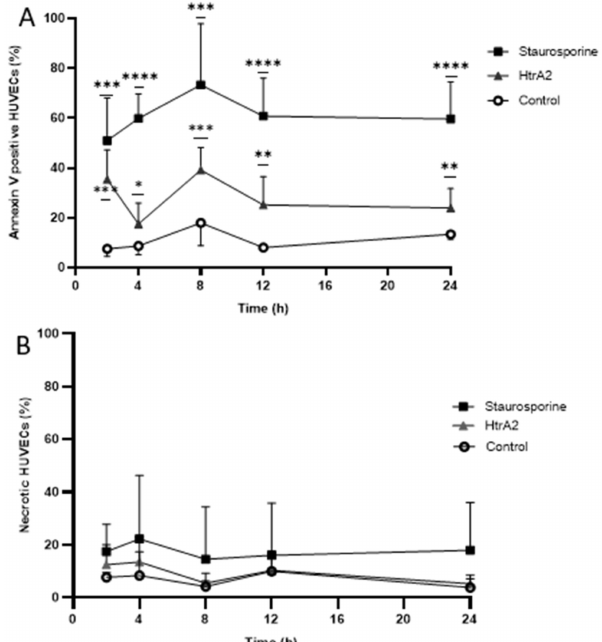
Figure 2. Extracellular HtrA2-induced apoptosis ( A ) but not necrosis ( B ) in HUVECs. HUVEC were stimulated with (2 µ g / mL) of recombinant HtrA2, staurosporine (200 nM) or vehicle for a 24-h period. Results are presented as means with S.D. Significantly di ff erent compared to corresponding control